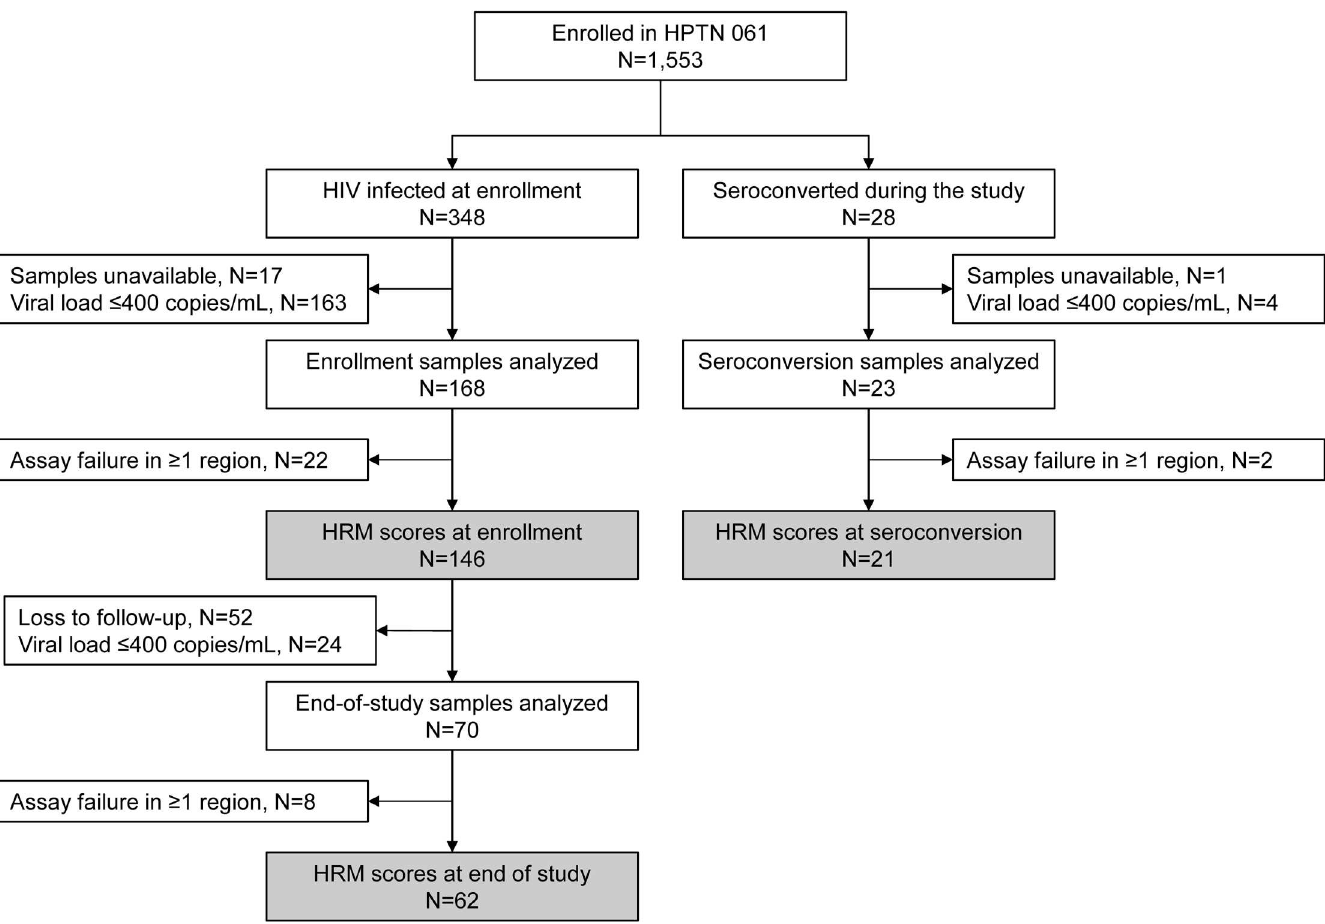
Fig 1. Study cohort. The high resolutionmelting(HRM) diversity assay was performed for a subset of men in HPTN 061. Data was analyzedfor men who had HRM scores determined for all six regions in the HIV genome(shadedboxes).